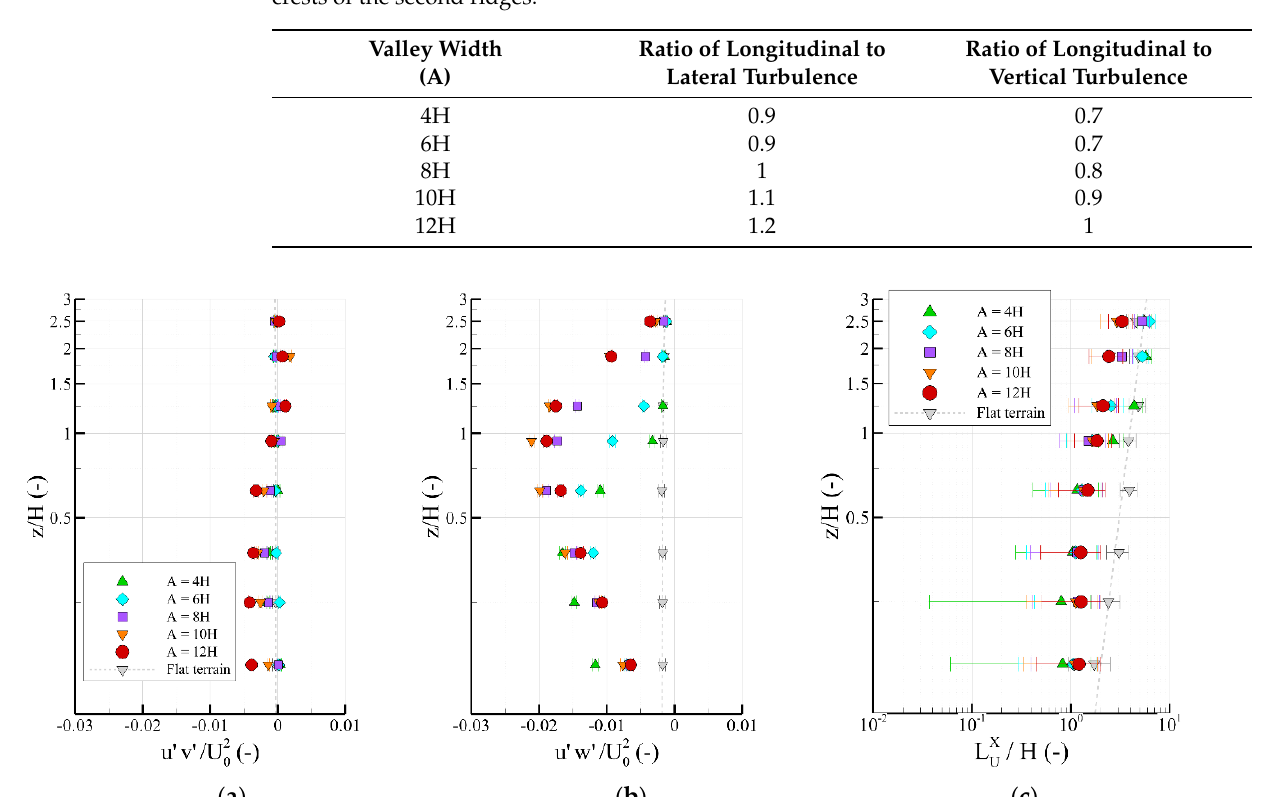
Table 3. Average ratios of longitudinal to lateral and vertical turbulence from z/H ≤ 1.25 above the crests of the second ridges.